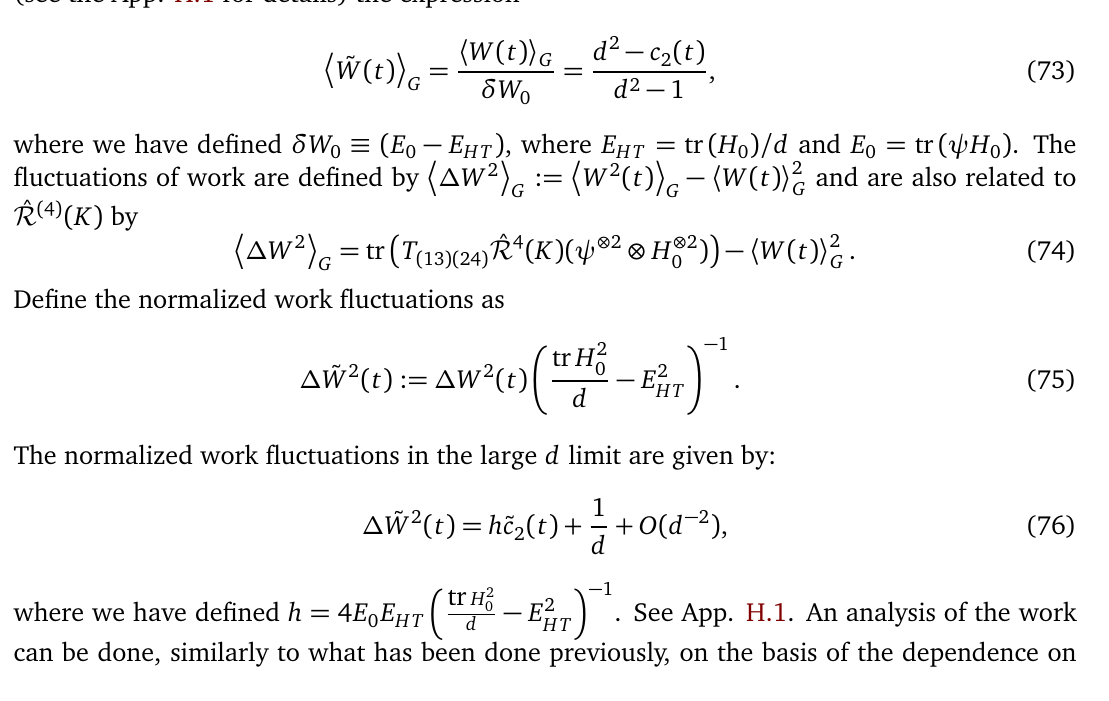
E Figure 9: Log-Log plot of 〈 f ( t ) 〉 , see Eq. (69), for d = 2 16 and d G aged over Poisson, GDE and GUE ensemble. The convergence to equilibrium is gov- erned by ˜ c ; we observe that GDE, GUE and Poisson equilibrate differently: in a time 4 (cid:112) O ( log d ) , O ( d 1 / 12 ) and O ( d 1 / 8 ) respectively (cfr. Table